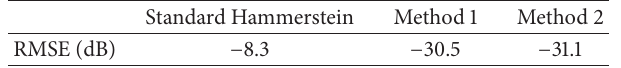
Table 2: RMSE between the signal backscattered by the contrast agent and that modeled with the Hammerstein model, method 1, and method